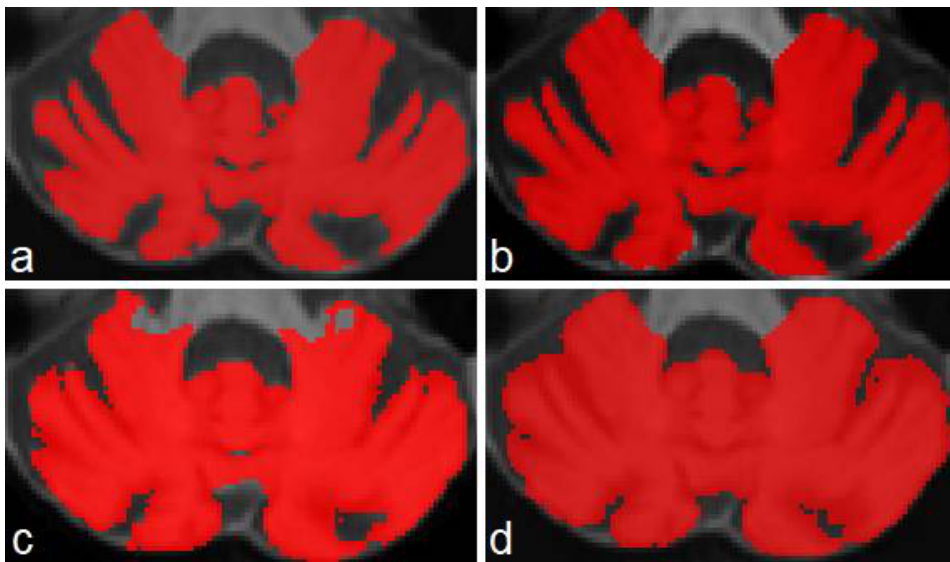
Figure 5. Example of segmentations produced by the approaches for a sample image from our da- taset. Original mask ( a ), followed by segmentation produced by M2 ( b ), CERES ( c ) and ACAPULCO ( d ). Table 8. OC comparison between our M2 model, ACAPULCO and